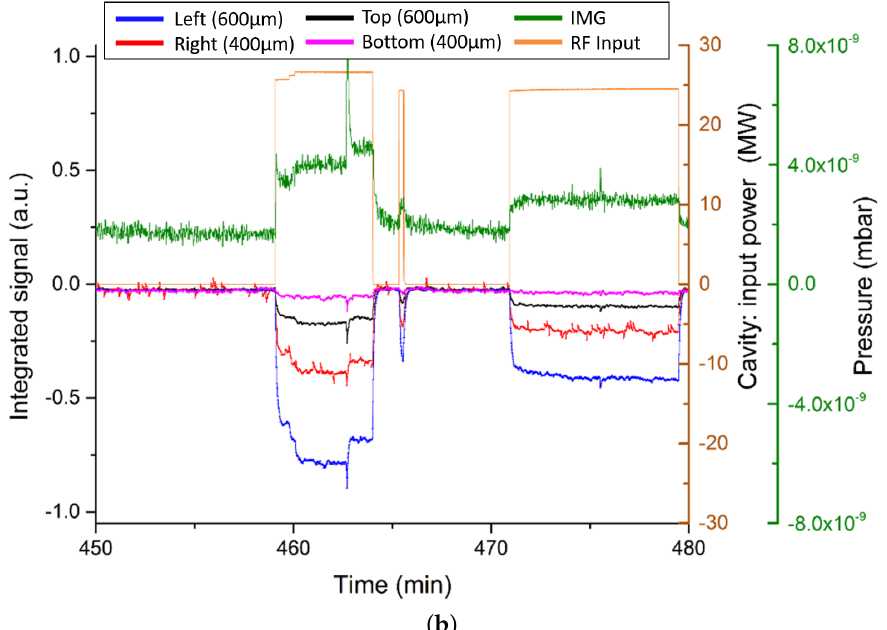
Figure 13. The Cherenkov signals for the four fibres as a function of time during RF conditioning. Fur- thermore, presented are the readings from the IMG and RF input power during the same time period. ( a ) is for a period of RF input power ramping up with no RF breakdowns and ( b ) includes two RF